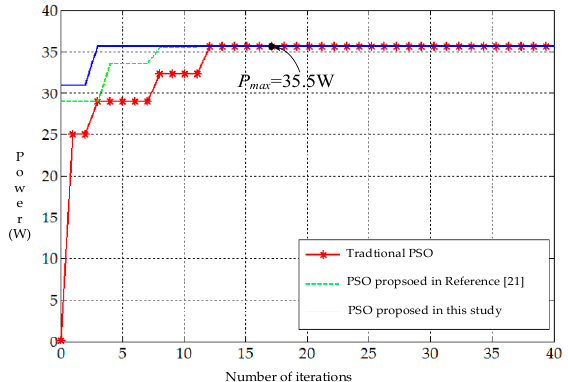
Figure 10. Comparison reuslts of maximum power tracking in Case 2 using the traditional PSO, the improved PSO in Reference [21], and the PSO proposed in this study.